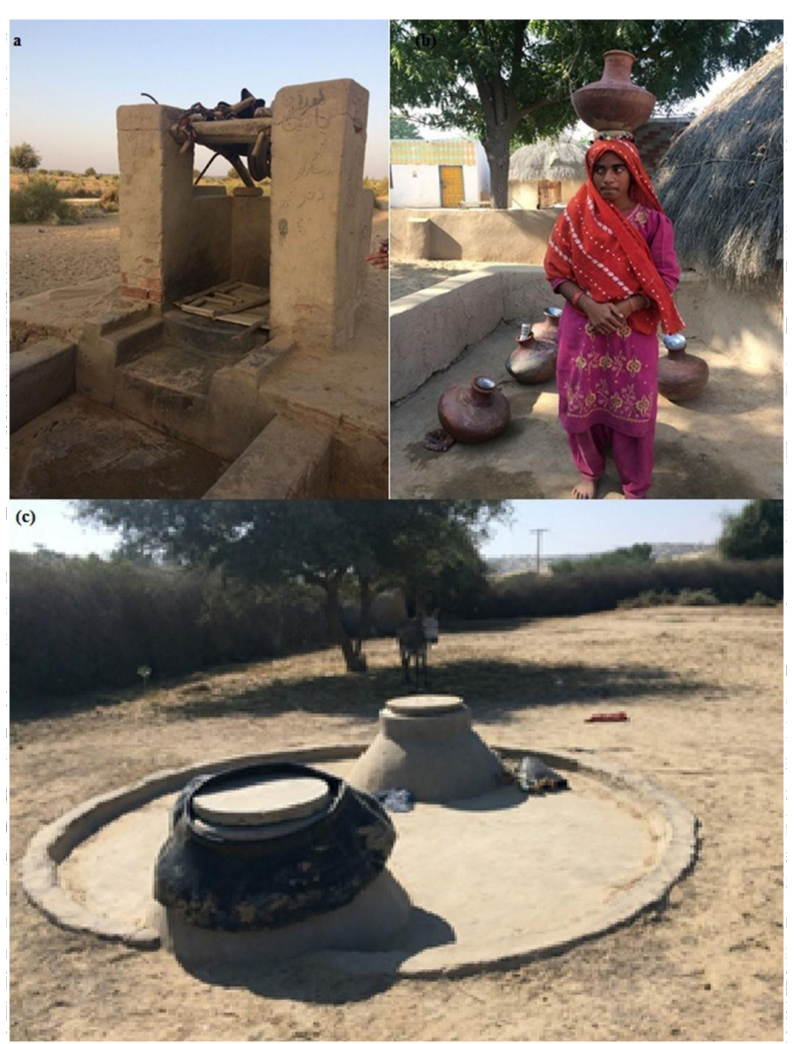
Figure 3. ( a ) Water wells, ( b ) Women carrying the mud container to fetch water, ( c ) Rain water storage containers